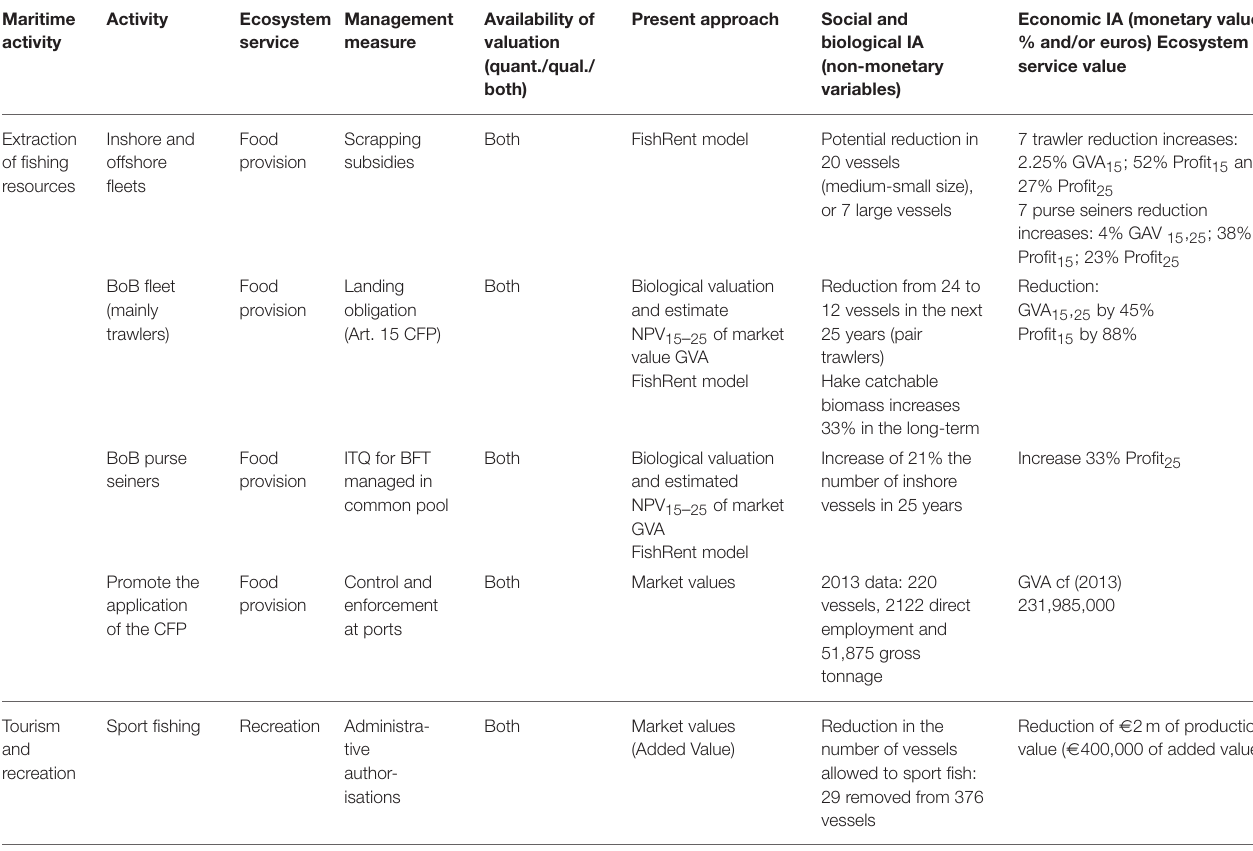
TABLE 7 | Bio-socioeconomic impact on ecosystem services resulting from management measures on Bay of Biscay maritime